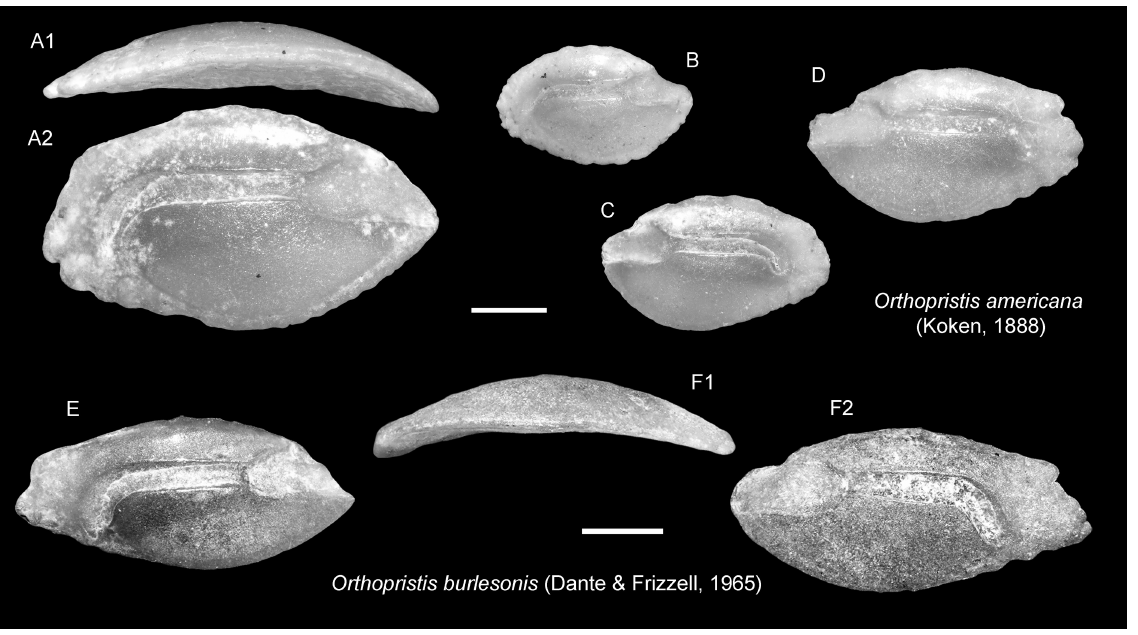
Fig. 31. Fish otoliths from the US middle and upper Eocene. A–D . Orthopristis americana (Koken,